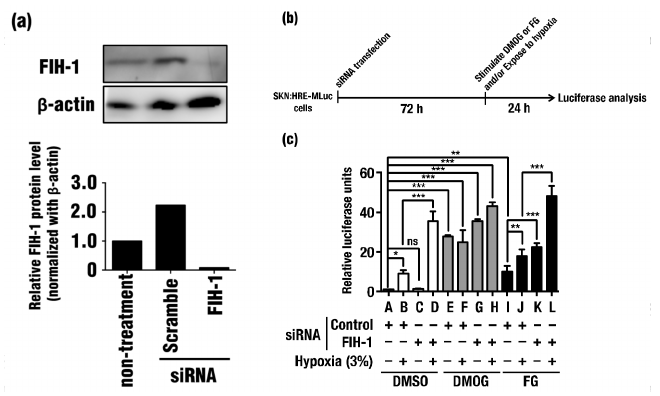
Figure 3. Establishment of the evaluation system for FIH-1 inhibitor activity. ( a ) Confirmation of siRNA knockdown efficiency for FIH-1. Scrambled siRNA and siRNA against FIH-1 were introduced into SK-N-BE(2)c cells. Transfected cells were cultured for 72 h with siRNA. After an additional 24 h, total cell lysates were analyzed by immunoblotting to detect FIH-1 or β -actin, which was used as an internal control; ( b ) Experimental design of the evaluation system for FIH-1 inhibitor activity; ( c ) HIF transcriptional activities were measured with secretion-type luciferase ( Metridia longa luciferase,